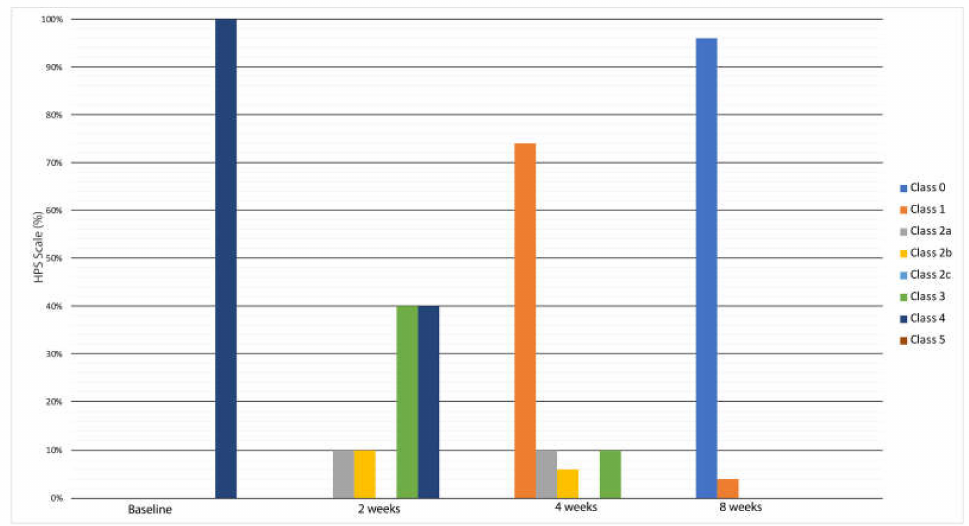
Figure 3. Evaluation of the quality of the wound-surrounding skin during treatment applications by the HPS score. All wounds progressively changed from class 3 to class 1 after 4